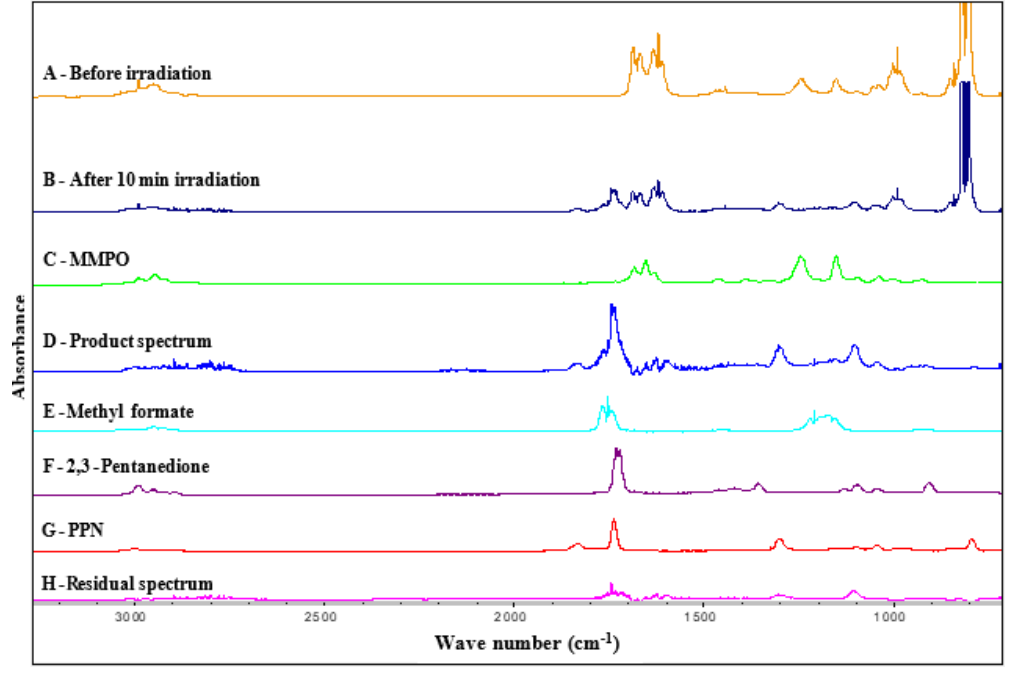
Figure 5. Infrared spectral data. Trace A: infrared spectrum of an MMPO / CH 3 ONO / air reaction mixture before irradiation. Trace B: mixture after 10min irradiation. Trace C: reference spectrum of MMPO. Trace D: product spectrum. Trace E: reference spectrum of methyl formate. Trace F: reference spectrum of 2, 3-pentanedione. Trace G: reference spectrum of PPN. Trace H: residual spectrum after subtraction of the identified reaction products in trace D.